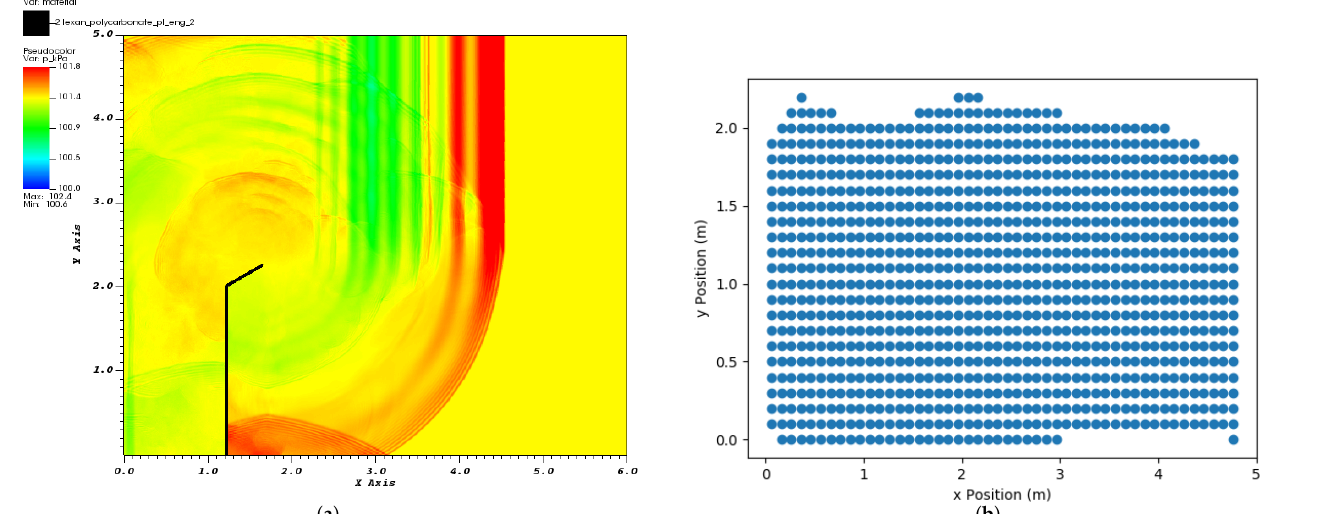
Figure 12. Results from a plane strain analysis of a single-fairing mitigation barrier loaded by a wave generated from 0.06123 kg of TNT at approximately 36.576 m. ( a ) A snapshot of the wave reflecting over the barrier. The color gradient is set so that max (red) values are above the 0.4516 kPa overpressure threshold. ( b ) The “bubble” behind the barrier for which max overpressure was beneath 0.4516